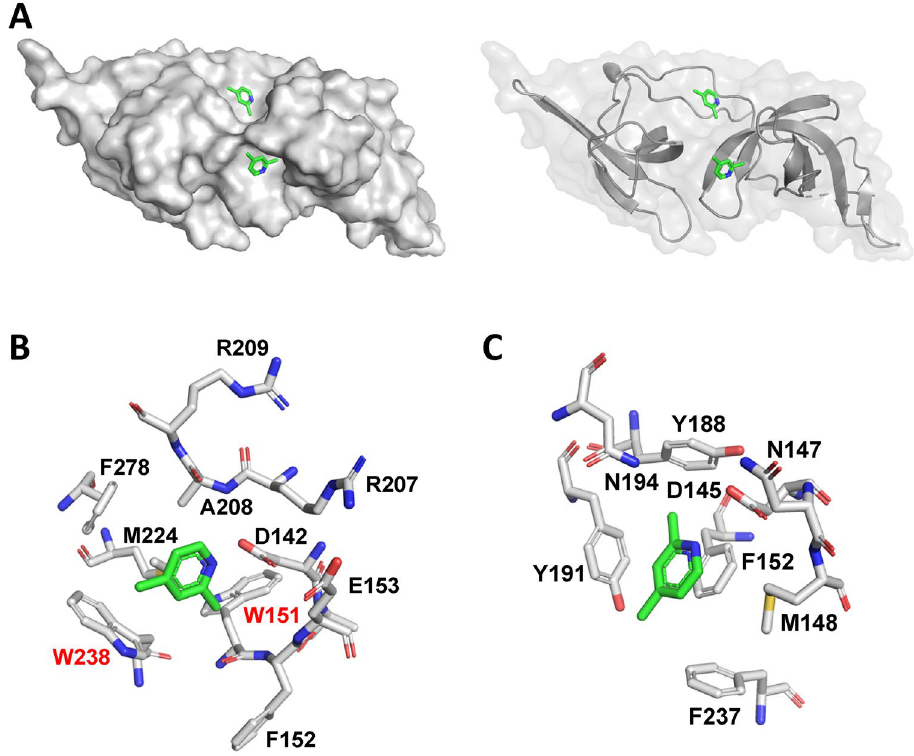
Figure 4. X-ray co-crystal structure elucidates the binding mode of 2,4-lutidine to TTD. ( A ) 2,4-Lutidine binds to two sites on TTD. ( B ) 2,4-Lutidine binds to the Arg-binding cavity of TTD. The two tryptophans near the 2,4-lutidine binding site, W151 and W238 are labeled in red ( C ) 2,4-Lutidine also binds to the aromatic cage of